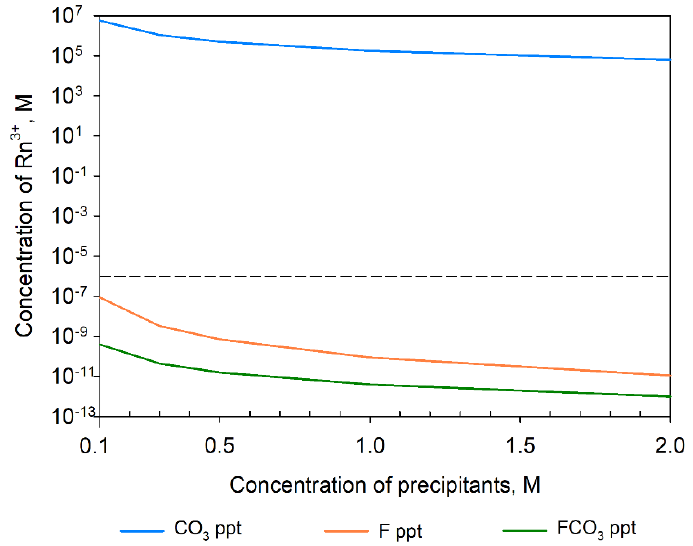
Figure 13. Equilibrium concentration of Rn 3+ with carbonate, fluoride, and fluoro-carbonate precipitate at pH 1 (dashed line: 1 ppm line). Table 8. Precipitation equations of Rn 3+ into various precipitants used in Figure 13.